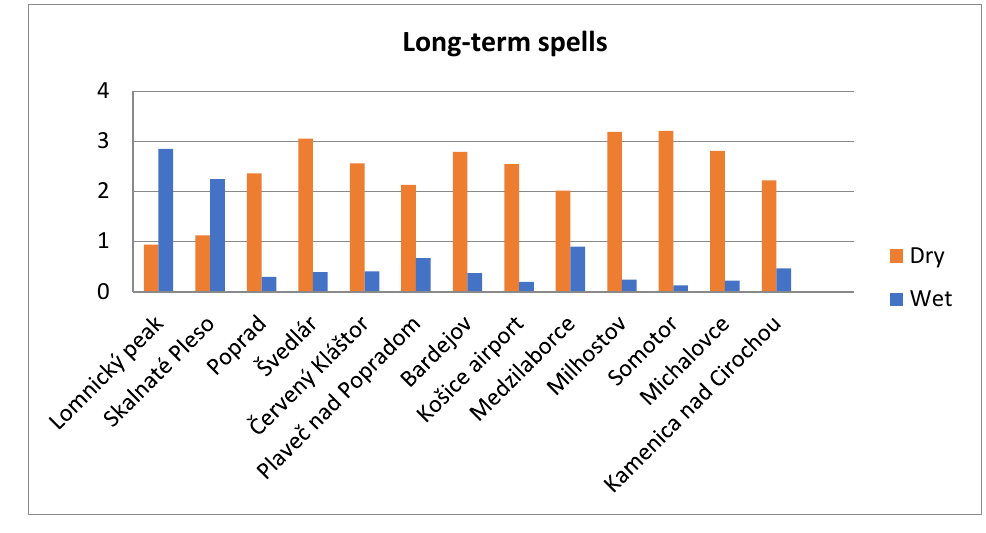
Figure 9. Number of wet/dry spells in climatic stations.